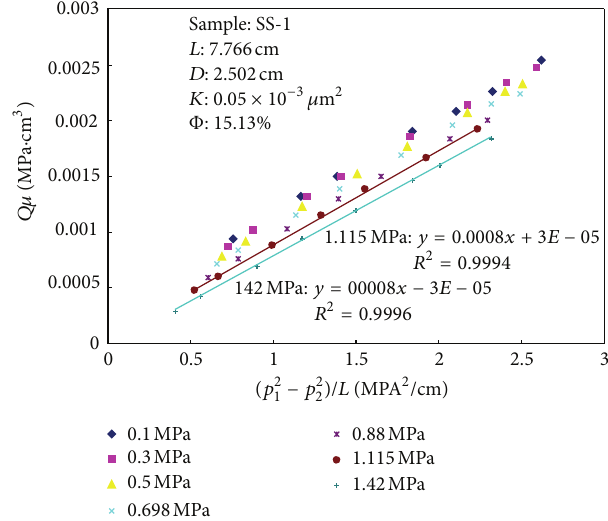
Figure 3: Relationships between (𝑝 2 1 − 𝑝 2 2 )/𝐿 and 𝑄𝜇 at various backpressures for sample SS-1.